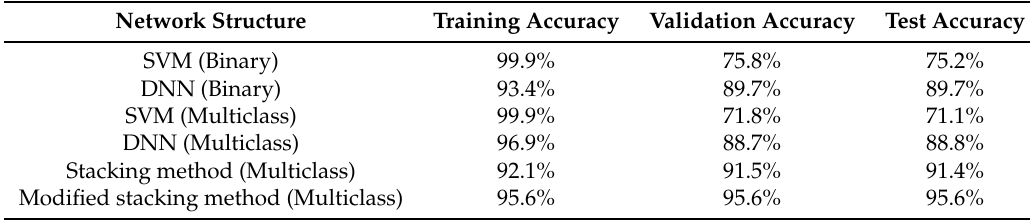
Table 6. The accuracy performances of the tested